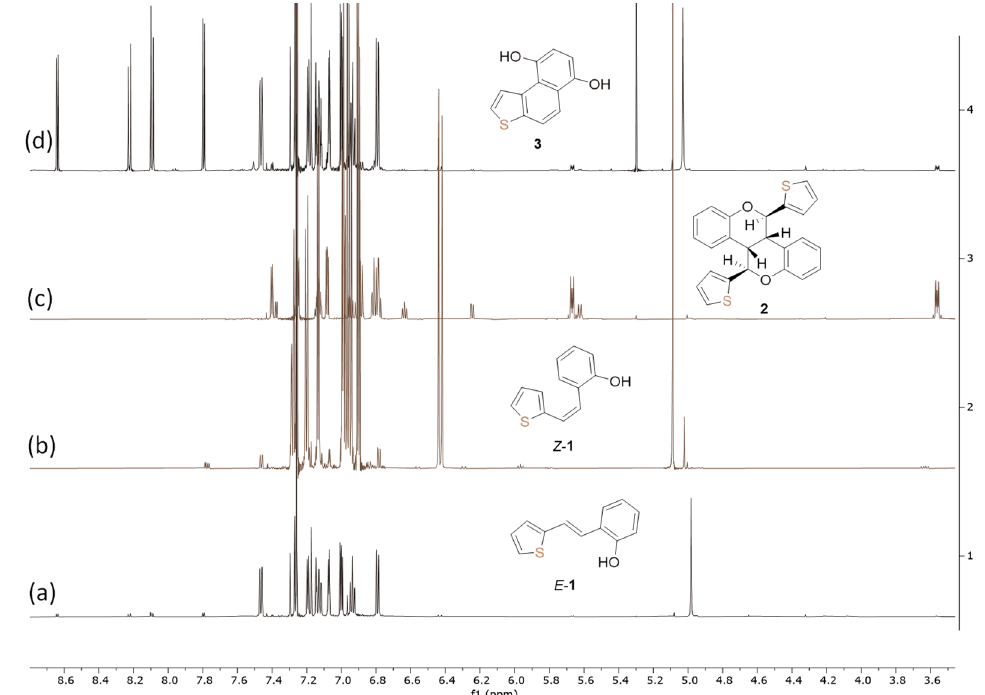
Figure 3. 1 H NMR spectra (CDCl 3 ) of the starting substrate E - 1 ( a ), and photoproducts Z - 1 ( b ), dimer 2 ( c ) and oxygenated cyclization product 3 ( d ). 2 ( c ) and oxygenated cyclization product 3 ( d